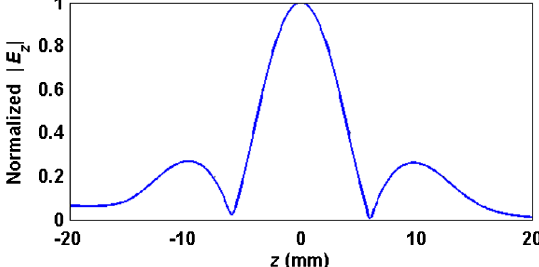
FIG. 11. The normalized magnitude of the electric field on z-axis of the HPBG-d3 structure simulated in HFSS.